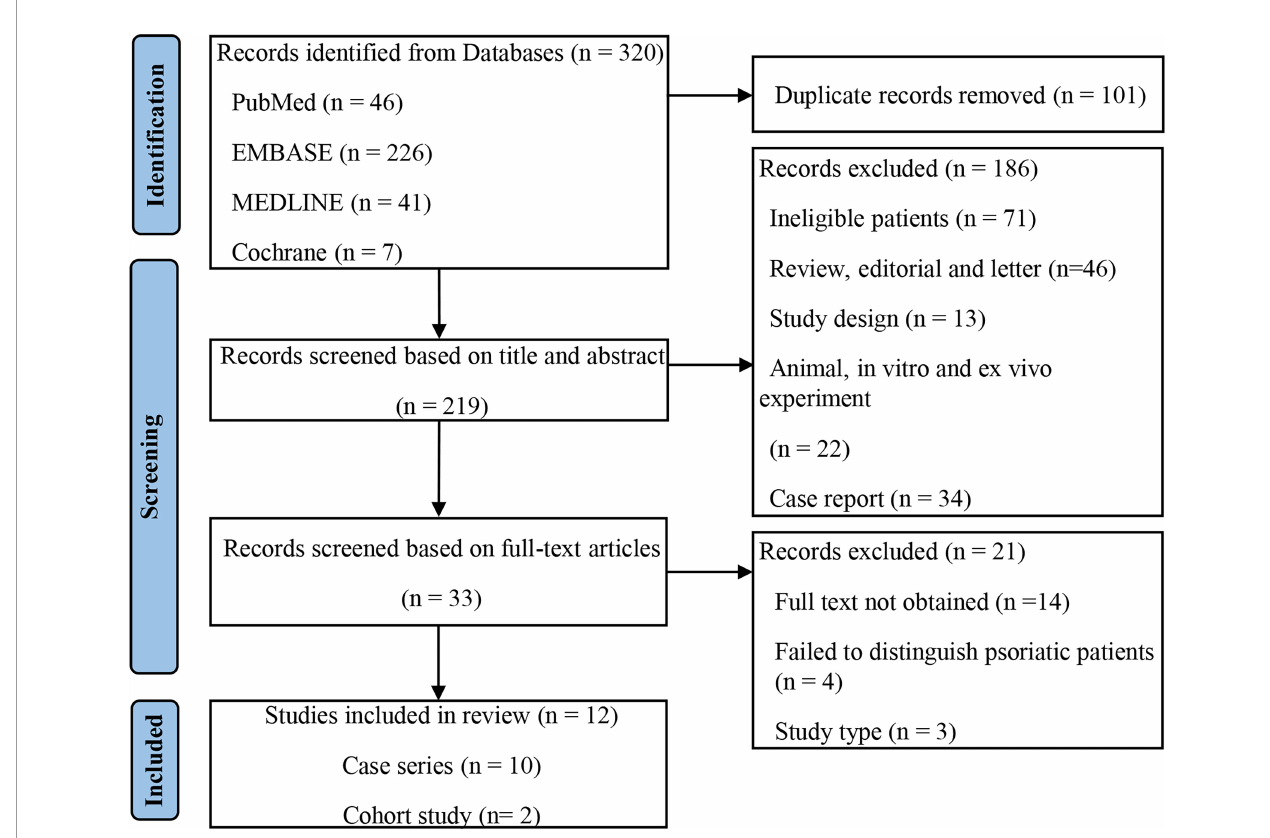
FIGURE 1 | Search and selection fl ow